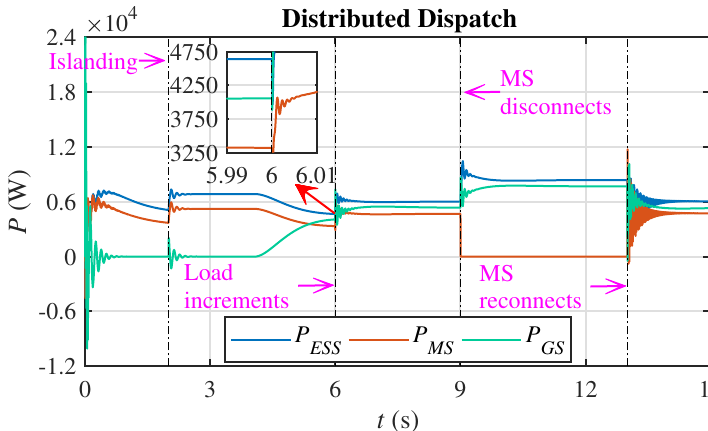
Figure 6. Power outputs of DGUs.